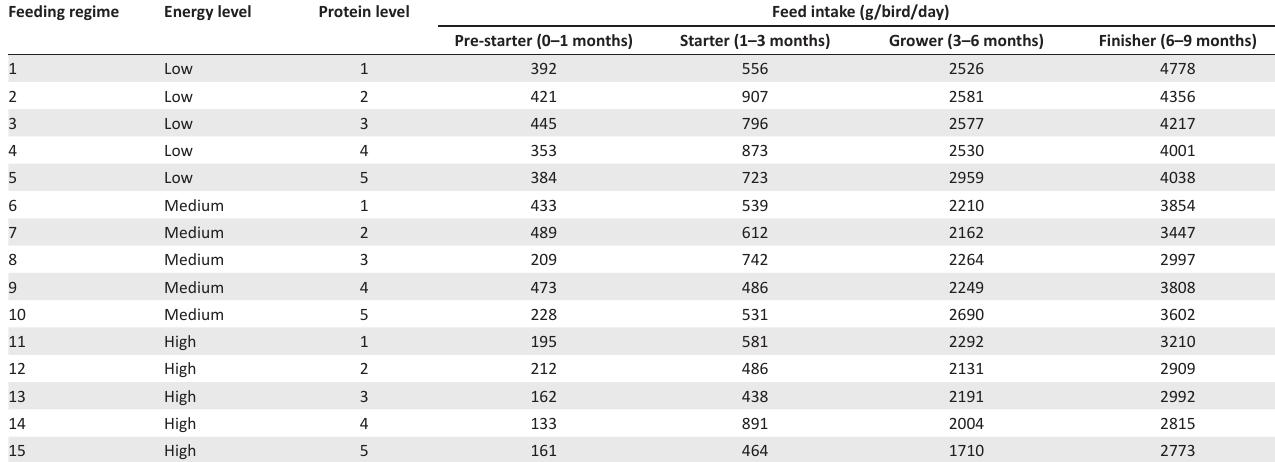
TABLE 3: A description of the average feed intake for the feeding regimes, with varying energy and protein levels provided to ostriches during the pre-starter, starter, grower and finisher phases. Feeding regime Energy